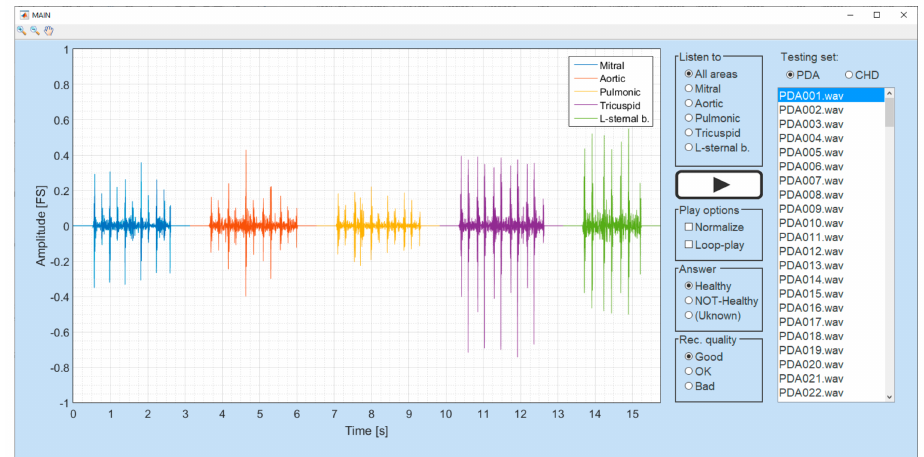
Figure 7. Graphic user interface for human performance assessment.